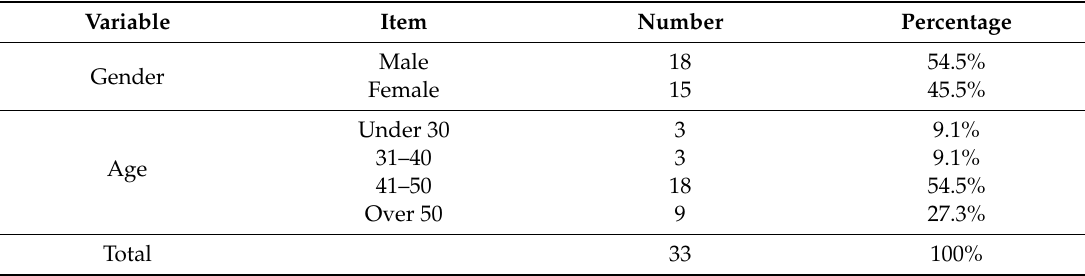
Demographic distribution for the computer-mediated communication (CMC) experimental group.